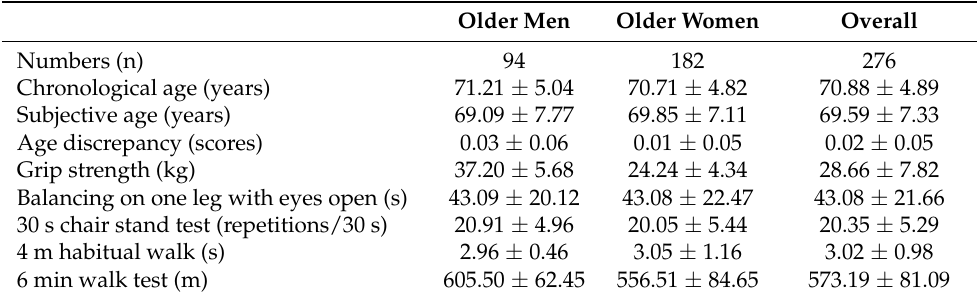
Table 1. The basic characteristics of the participants.